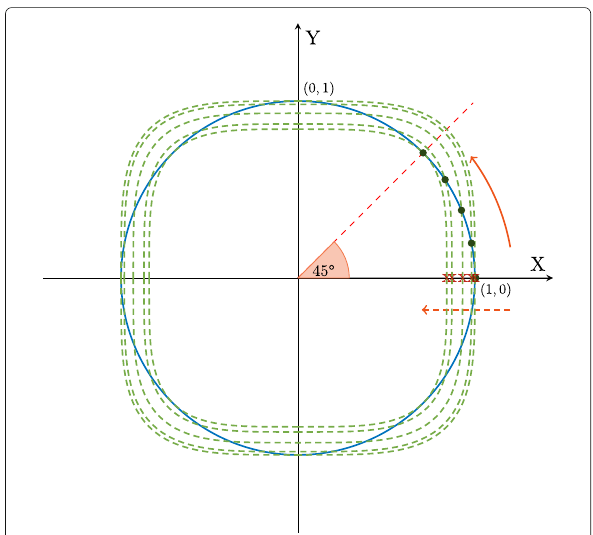
Fig. 5 2-D unit-ball illustration of the relation between the (cid:4) 2 -norm and